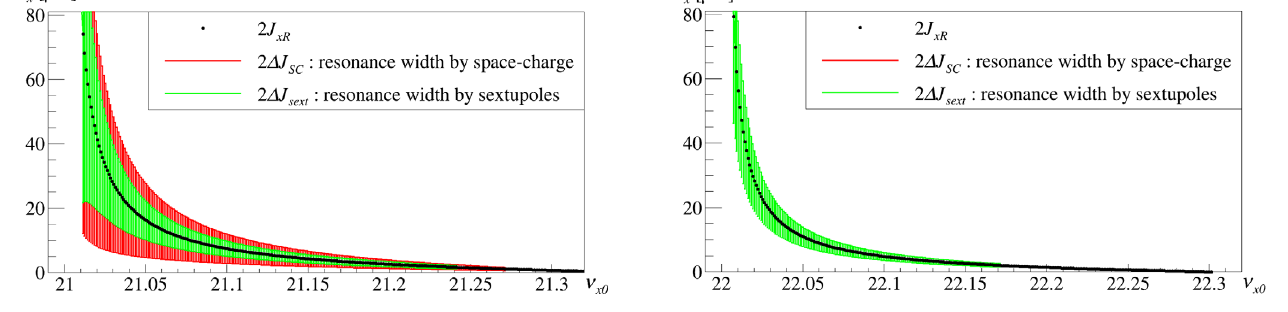
FIG. 14. The on-resonance actions 2 J xR and the resonance widths in the NX22 experiment as a function of the bare tune obtained from the analytical calculations. The horizontal axis represents the bare horizontal tune. The black points represent the in-resonance actions 2 J xR , and the green lines represent the resonance widths due to the sextupoles 2 Δ J . The resonance sext . width due to the space-charge (red line) does not appear because sext it is